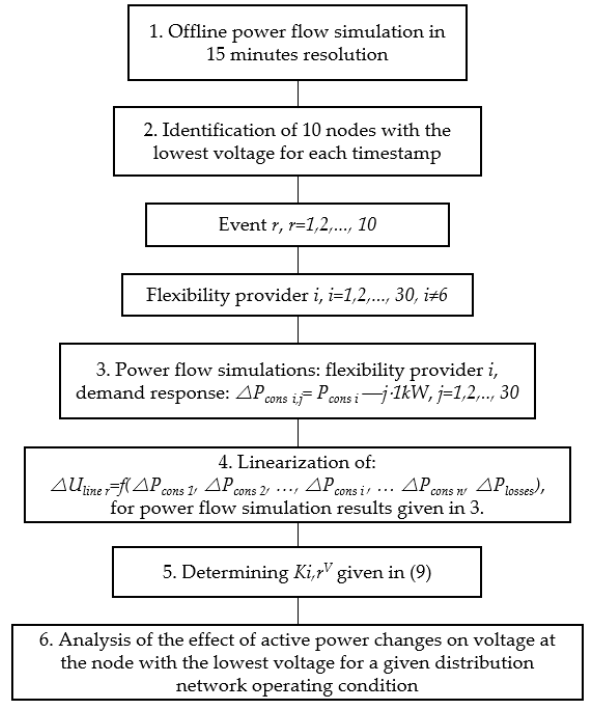
Figure 5. Algorithm for investigating impact of change in active power consumption of flexibility provider/asset on change in voltage at a node with the lowest voltage.